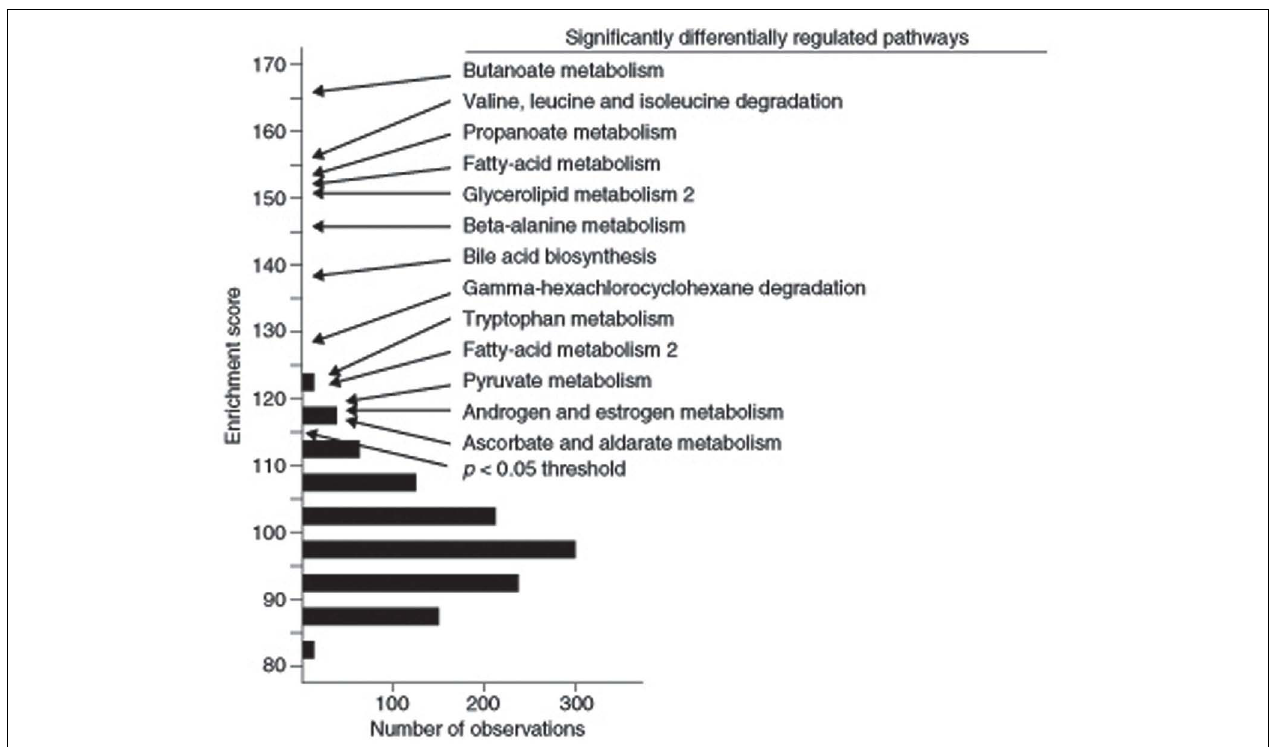
differentially expressed between lean and obese mice were identified. KEGG pathways enriched in the differentially expressed genes were then identified. Those exceeding a p -value of 0.05 in the enrichment score are indicated. [Figure from Ghazalpour et al. (2005) with